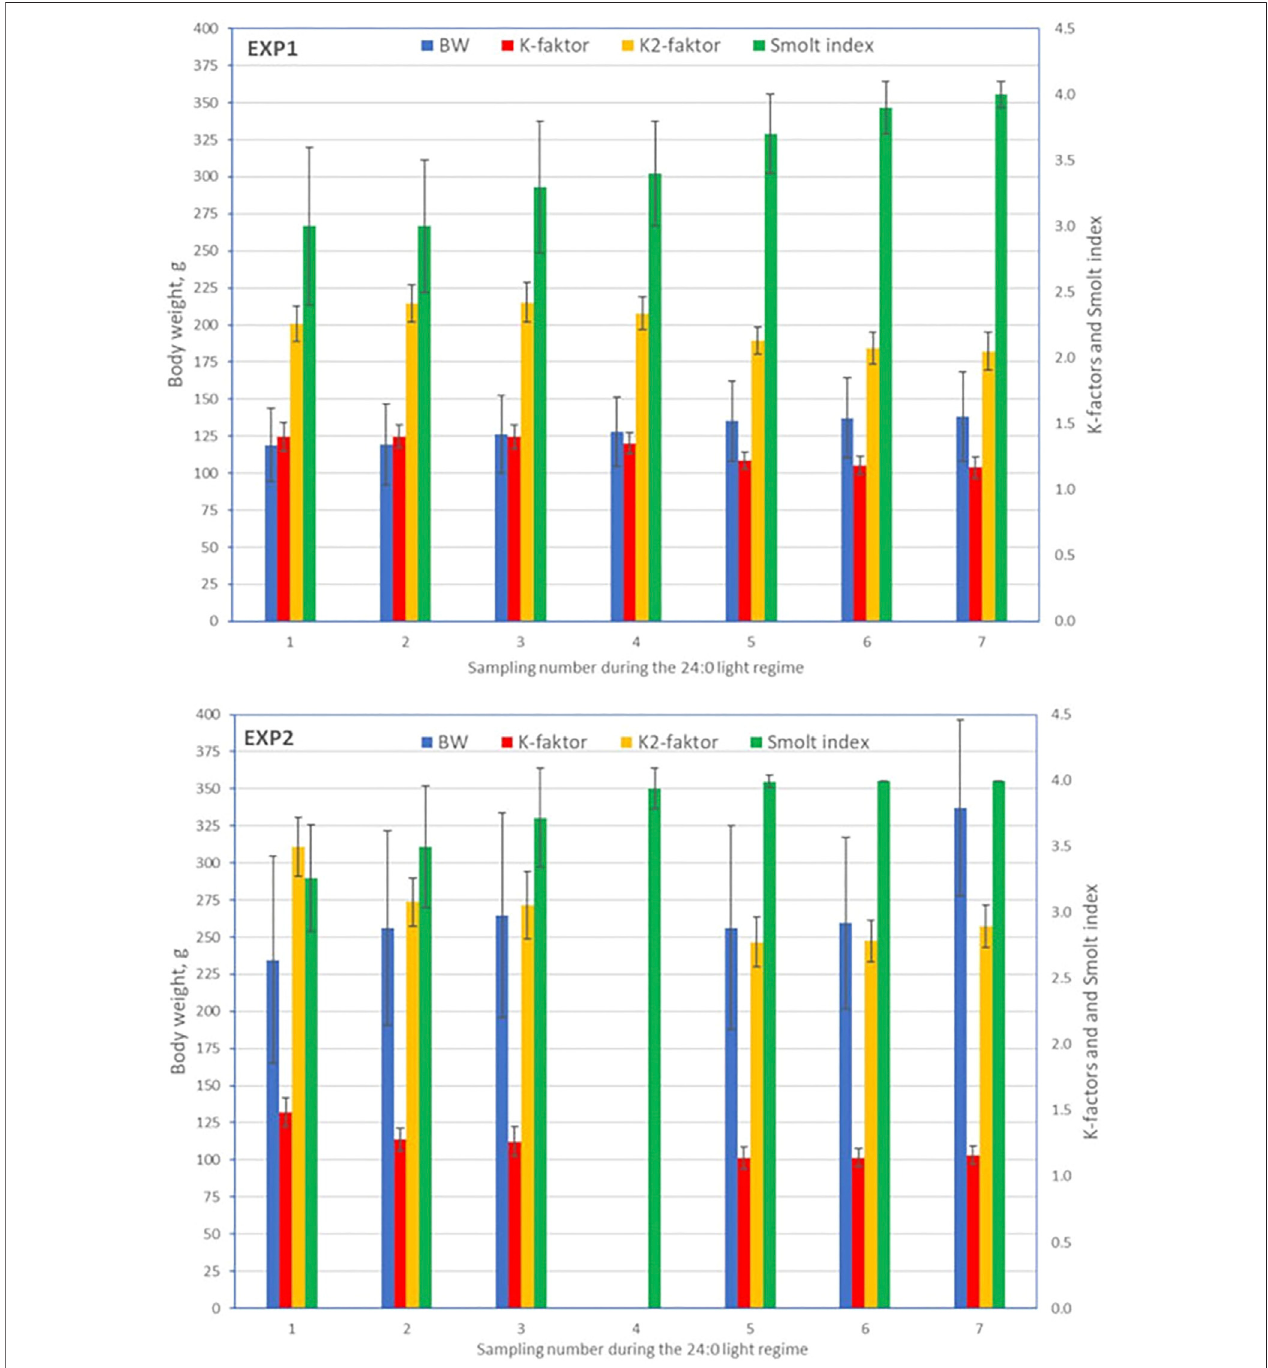
FIGURE 2 | Means ( ± standard deviations) for body weight, K-factor, K2-factor, and smolt index at each sampling for EXP1 and EXP2.